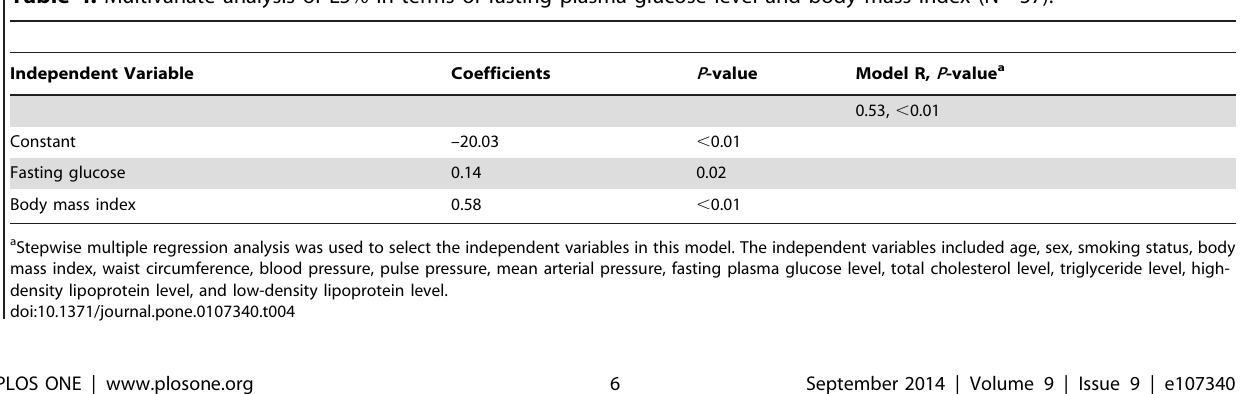
Table 4. Multivariate analysis of L5% in terms of fasting plasma glucose level and body mass index (N= 57).